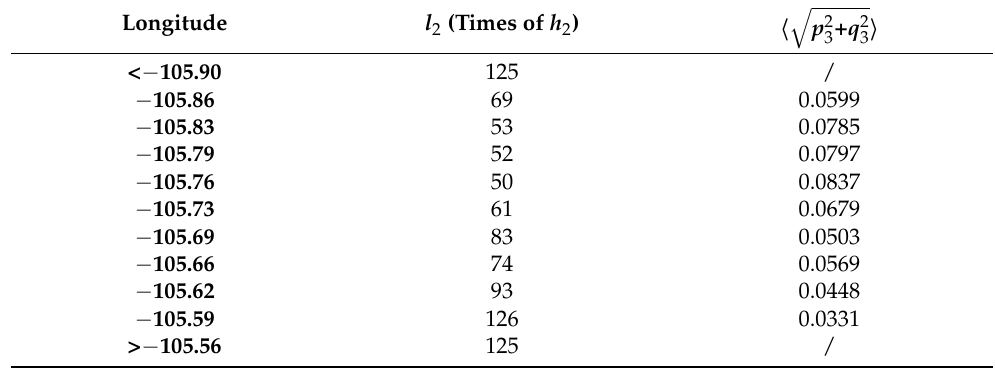
Figure 13. Track-wise comparison between AKS and CYGNSS v3.0 data from Physical Oceanography Distributed Active Archive Center (PODAAC). Table 8. Correlation length l 2 and coarse topography